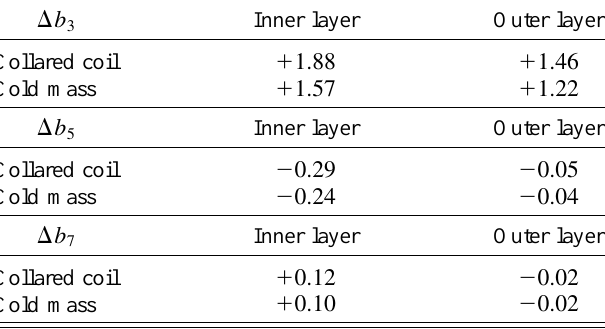
TABLE V. Effect on an additional shim of 0.1 mm on allowed multiples ( 10 2 4 units, R ref (cid:1) 17 mm): finite element results for collared coil and assembled cold mass at room